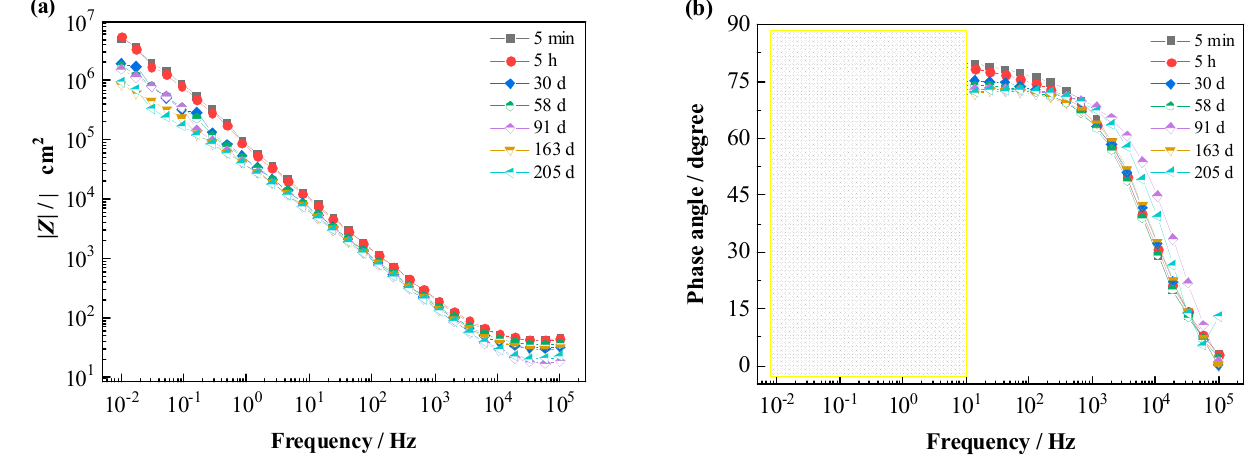
Figure 2. EIS Bode spectra of T700/VE composite in 3.5% NaCl solution. ( a ) Impedance modulus; ( b ) Phase